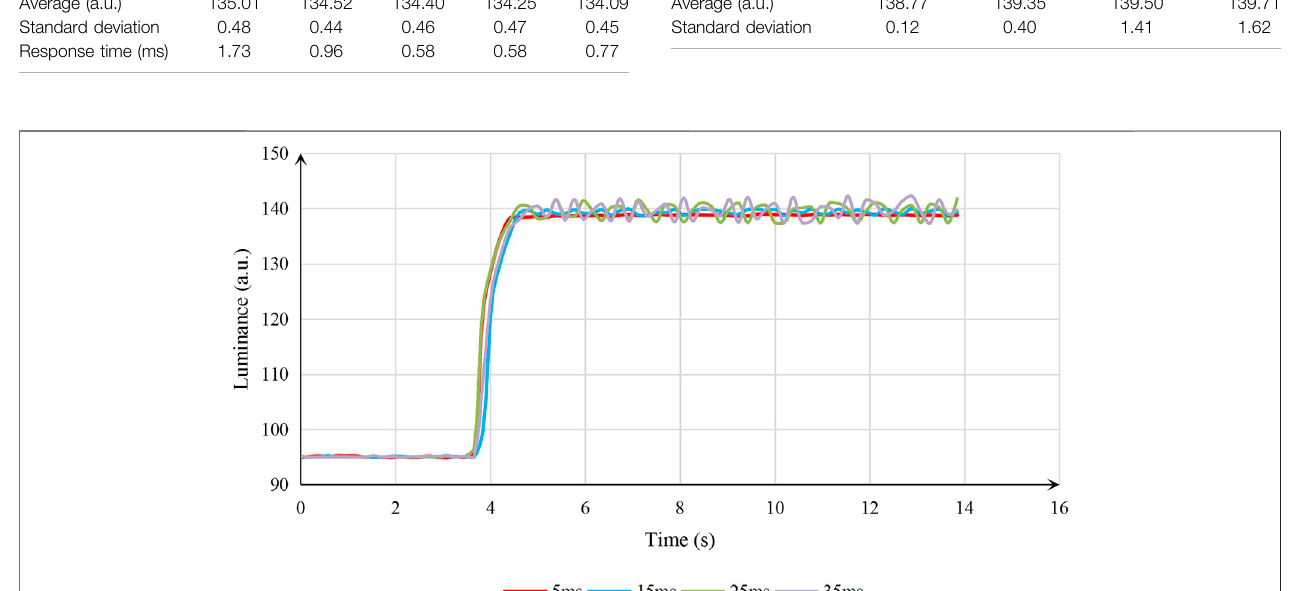
TABLE 3 | Driving effect comparison when different rising gradient driving waveforms were used to drive EWDs. Slope (V/ms) Average (a.u.)